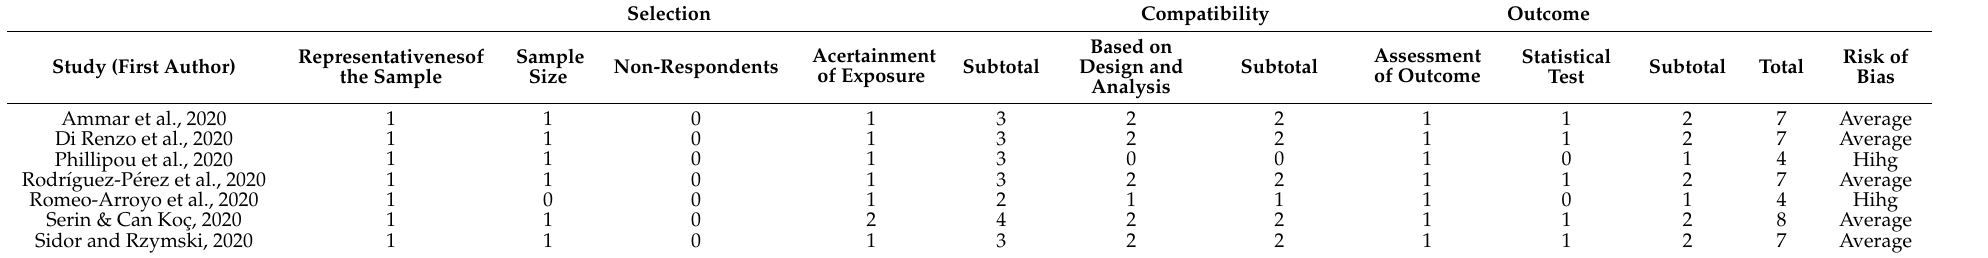
Table A2. Scores and criteria of cross-sectional studies through the NOS